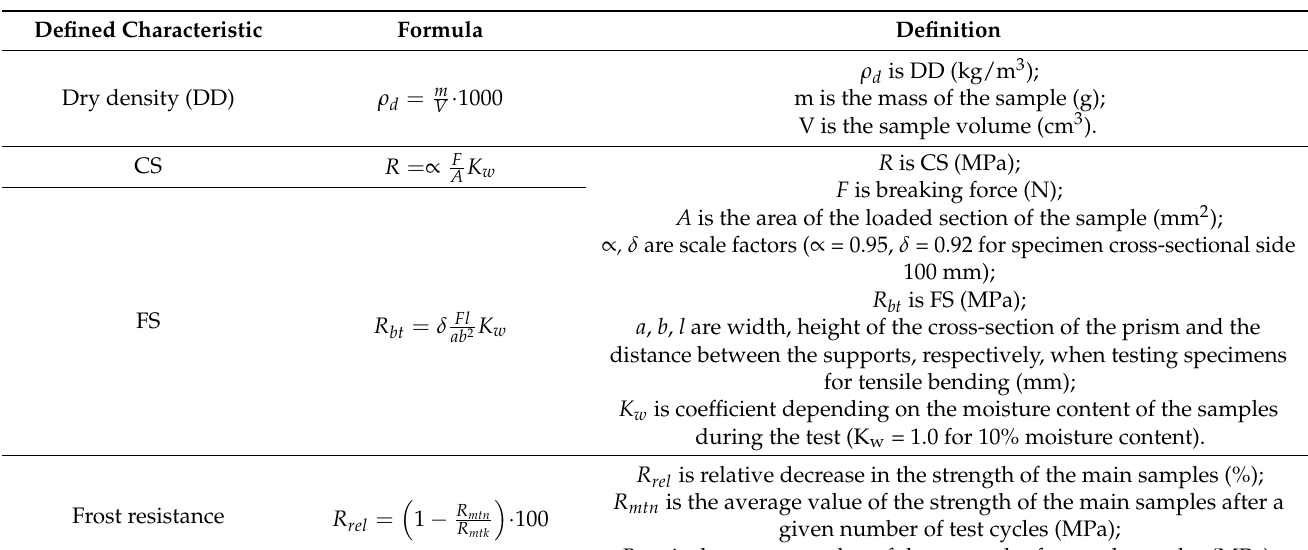
Table 6. Formulas for calculating the PC and MC of